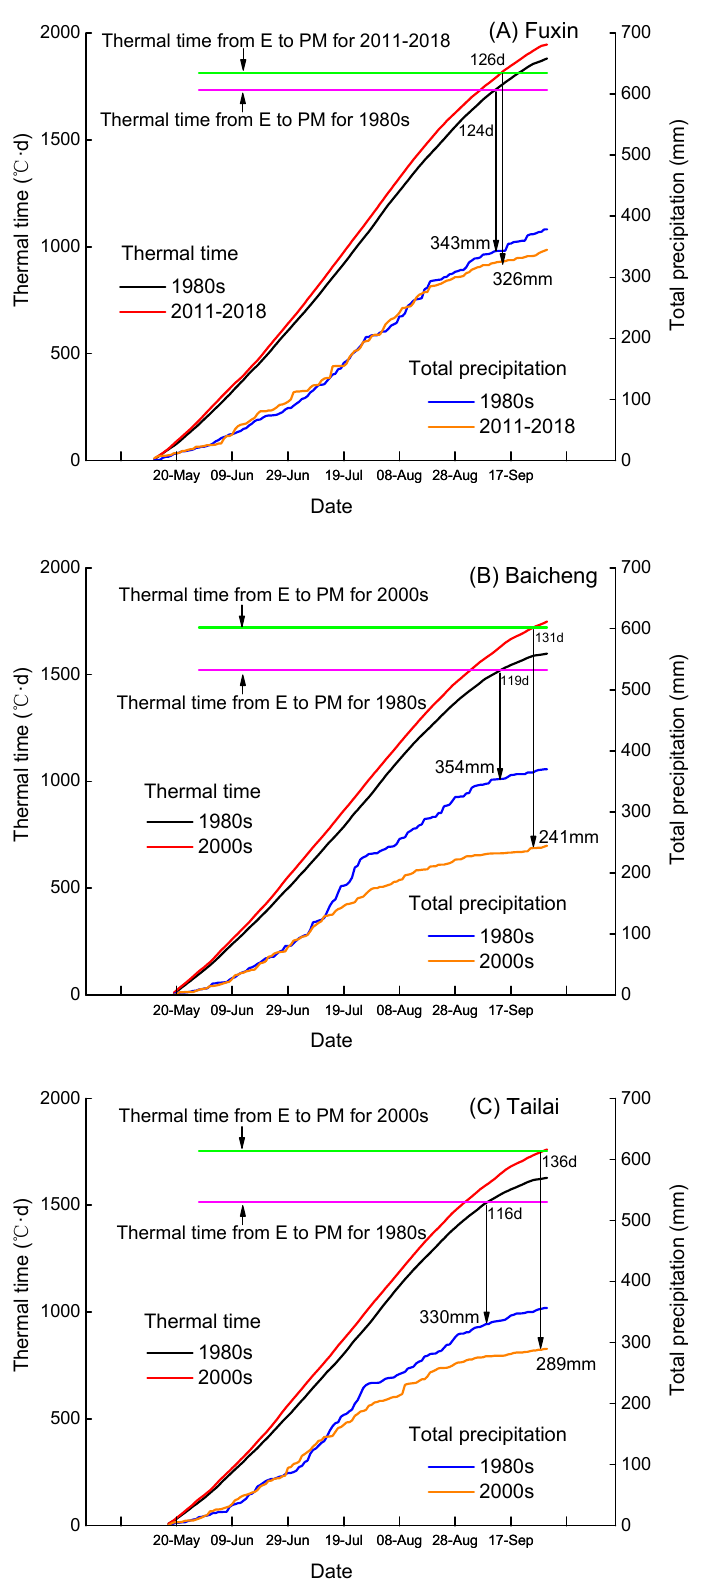
Figure 6. The correlations between thermal time and precipitation during the 1980s and 2000–2018 at Fuxin ( A ), Baicheng ( B ), and Tailai ( C ) stations. The emergence dates at the Fuxin, Tailai and Baicheng stations were 12 May, 17 May and 19 May, respectively, which were averaged using the observed data. Thermal time from emergence (E) to physiological maturity (PM) showed as horizontal